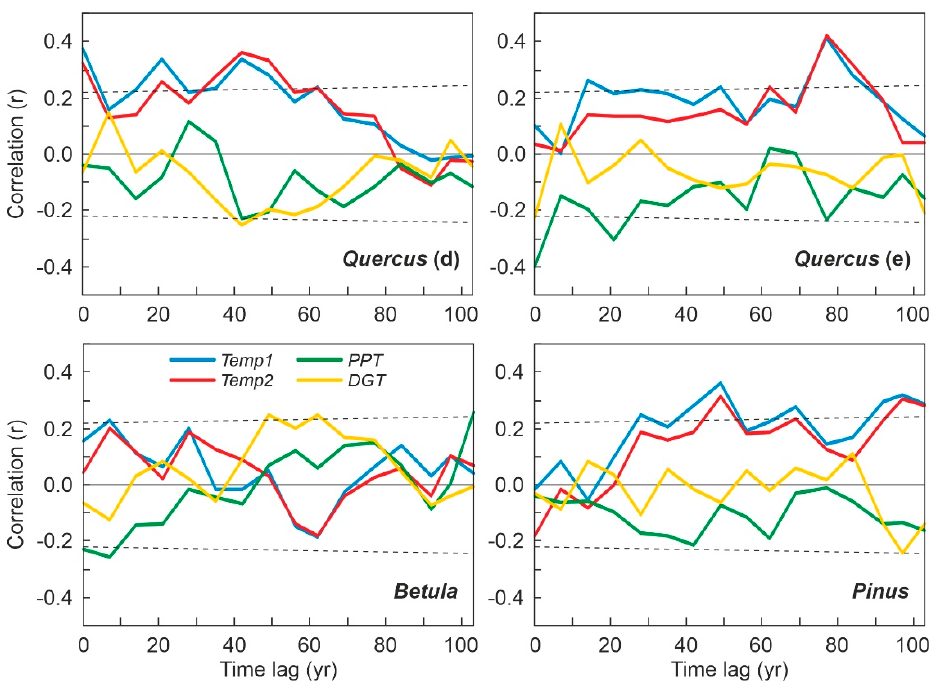
Figure 11. Response lags of the major forest components with respect to the climatic drivers. Only linear correlations have been considered in this case. The dotted lines represent the significant correlation values at p < 0.05, which show a slow increase as the number of samples decreases.